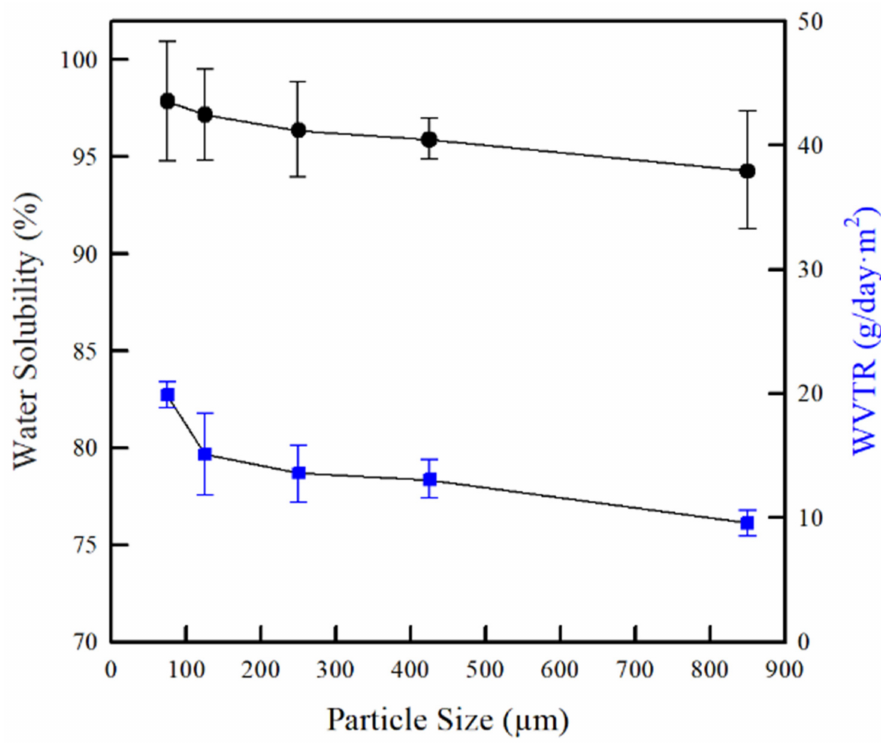
Figure 9. Effect of chitosan particle sizes on water solubility and water vapor transmission rate of CMCh